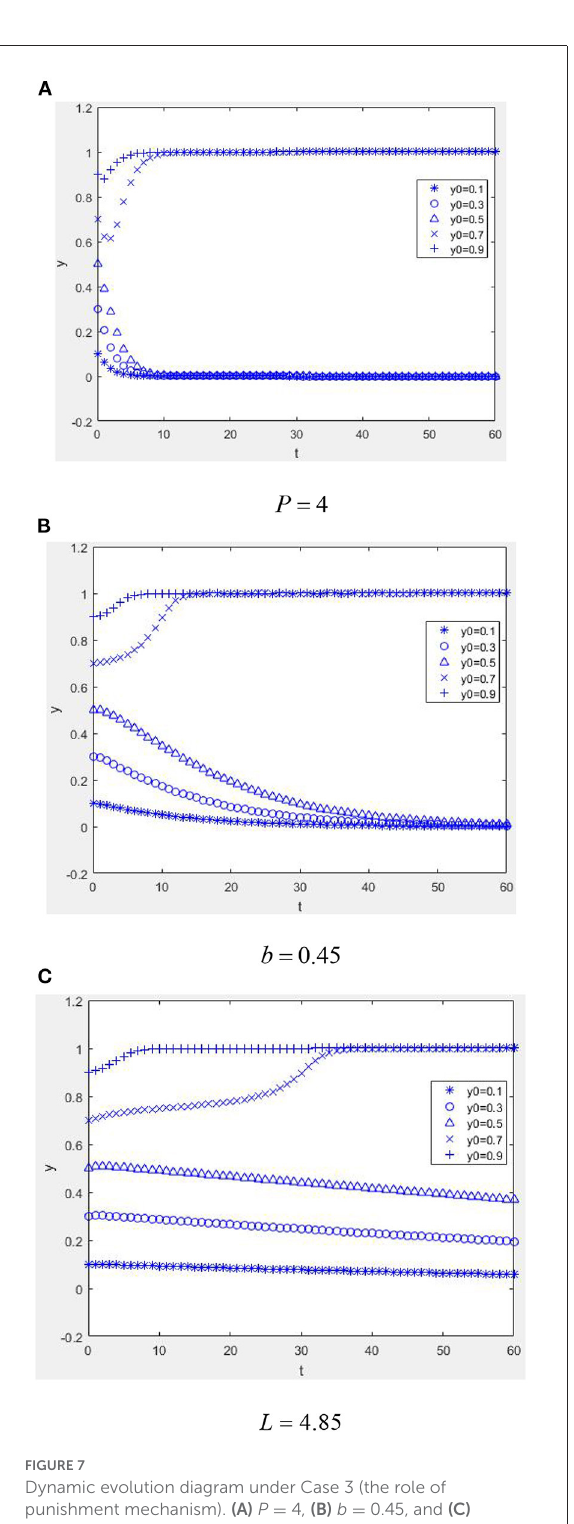
FIGURE7 Dynamic evolution diagram under Case 3 (the role of punishment mechanism). (A) P = 4, (B) b = 0.45, and (C) L =